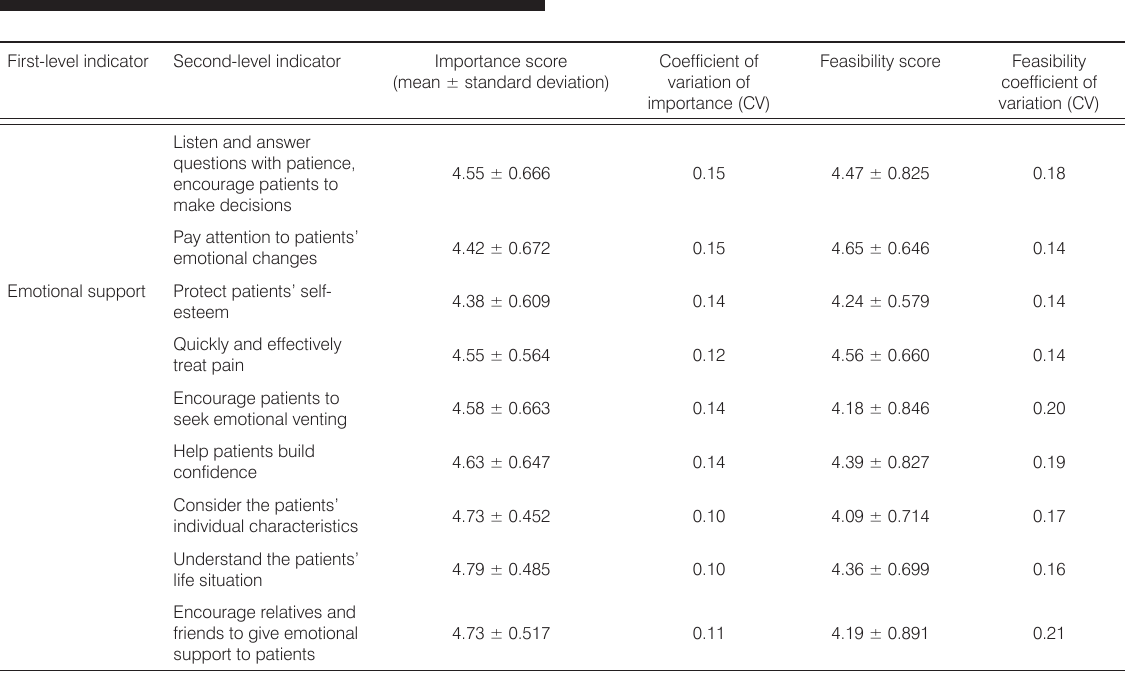
Table 2. Evaluation indicator system for inpatients’ nursing service needs in tertiary general